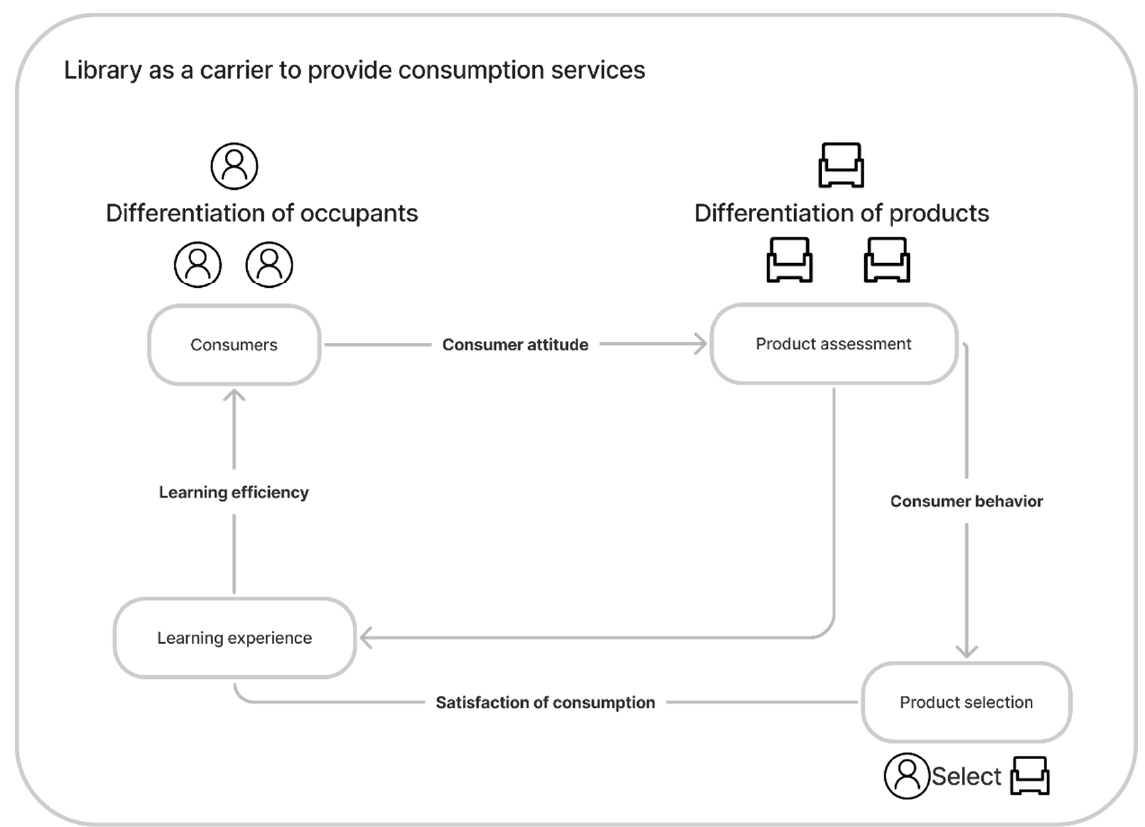
Figure 2. The relationship between people and libraries in the context of consumption.